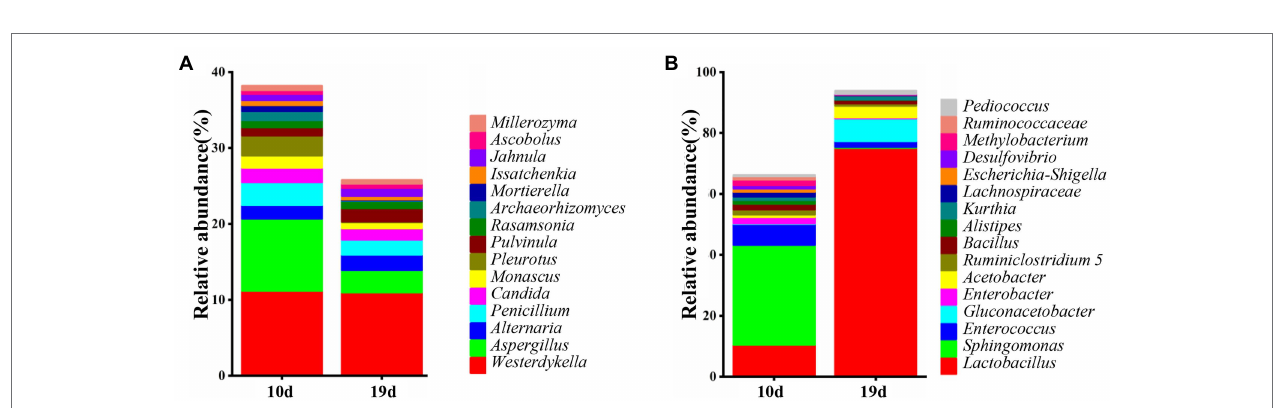
FIGURE 4 | Distribution of the fungi (A) and bacteria (B) during fermentation